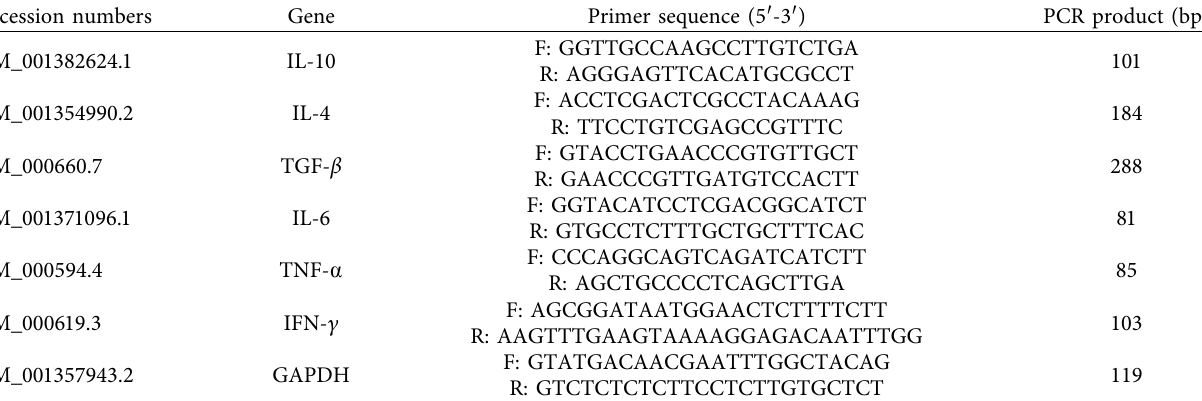
Table 1: Oligonucleotide primers.